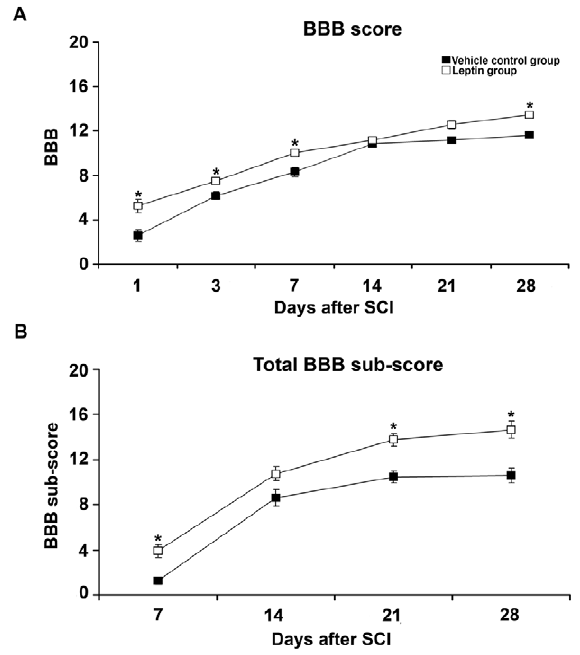
Figure 5. The effect of leptin administration on motor function recovery in the open-field test. (A) Recovery of motor functioning was determined using the Basso-Beattie-Bresnahan (BBB) locomotor scale. Leptin administration enhanced the recovery of motor functions at 1, 3, 7 and 28 d after SCI when compared with vehicle-treated controls. (B) The BBB sub-scores (7–28 d post-SCI) were significantly higher following leptin administration. In all cases, the values represent the mean 6 SEM; * p , 0.05 versus the vehicle control group.